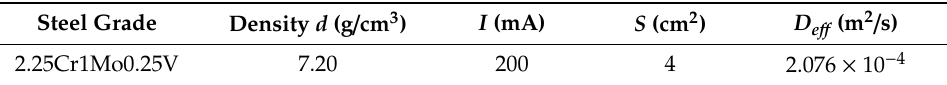
Table 2. Data for determining of hydrogen concentration on the charging